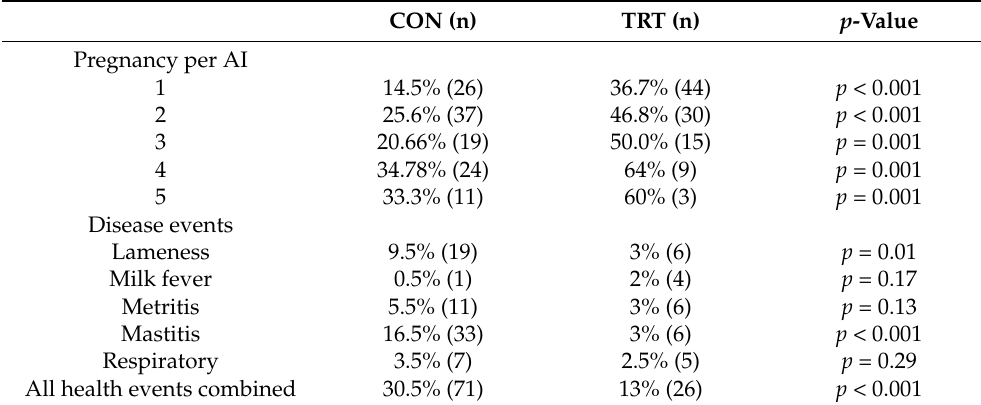
Table 1. Distribution of pregnancy per AI and cumulative frequency of diseases among the cows in treatment (TRT = no headlocks) and control groups (CON = regular headlock).